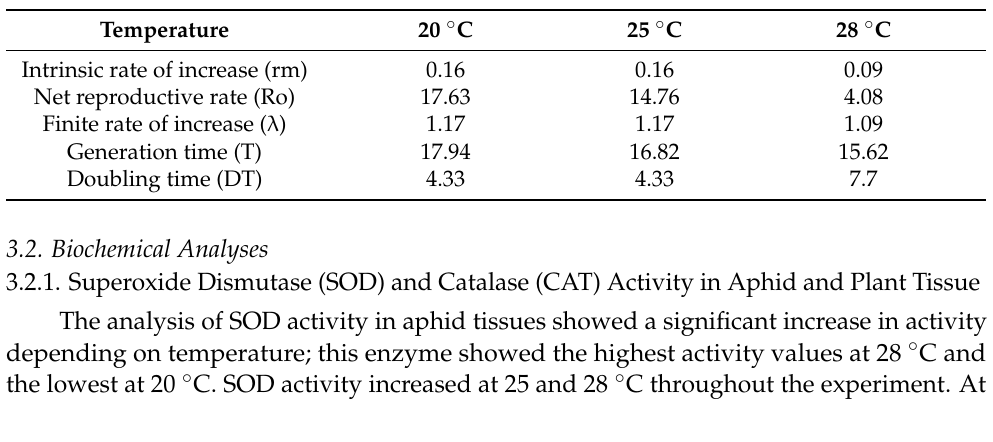
Table 1. Life parameters describing Macrosiphum rosae as a function of temperature.